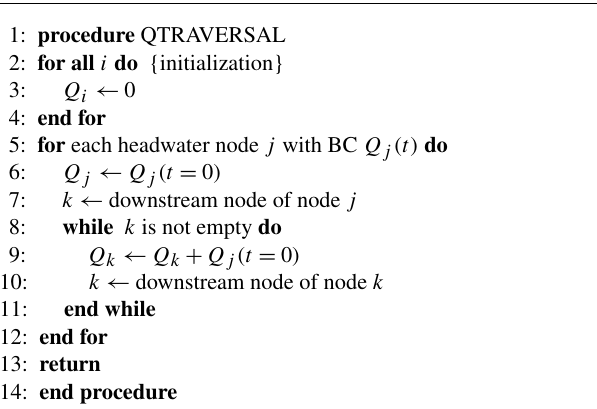
Algorithm 2 DFS traversal for